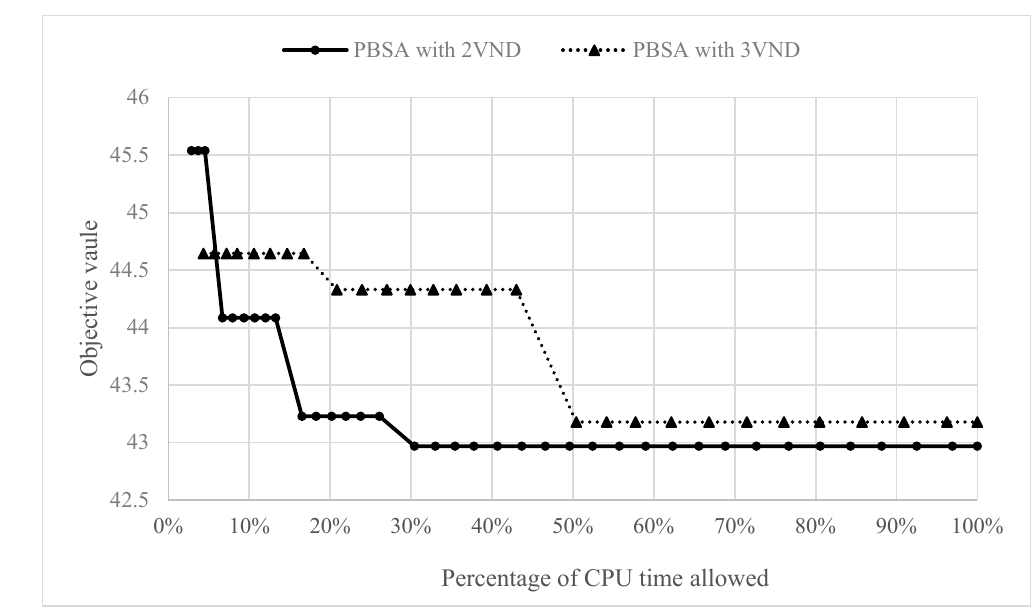
Figure 4. Convergence of the algorithm. Figure 7. Convergence of the